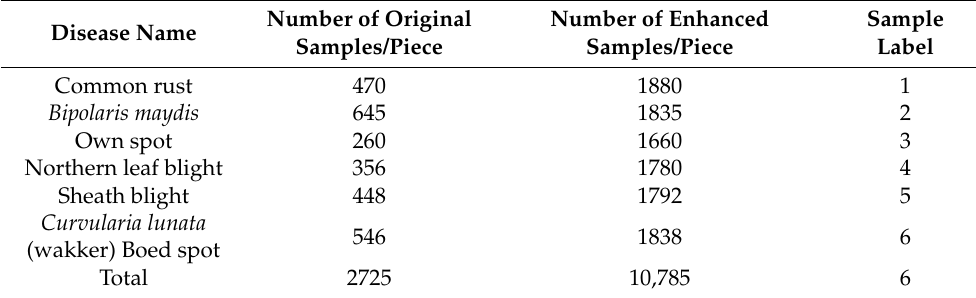
Table 1. Statistics of corn pests and diseases’